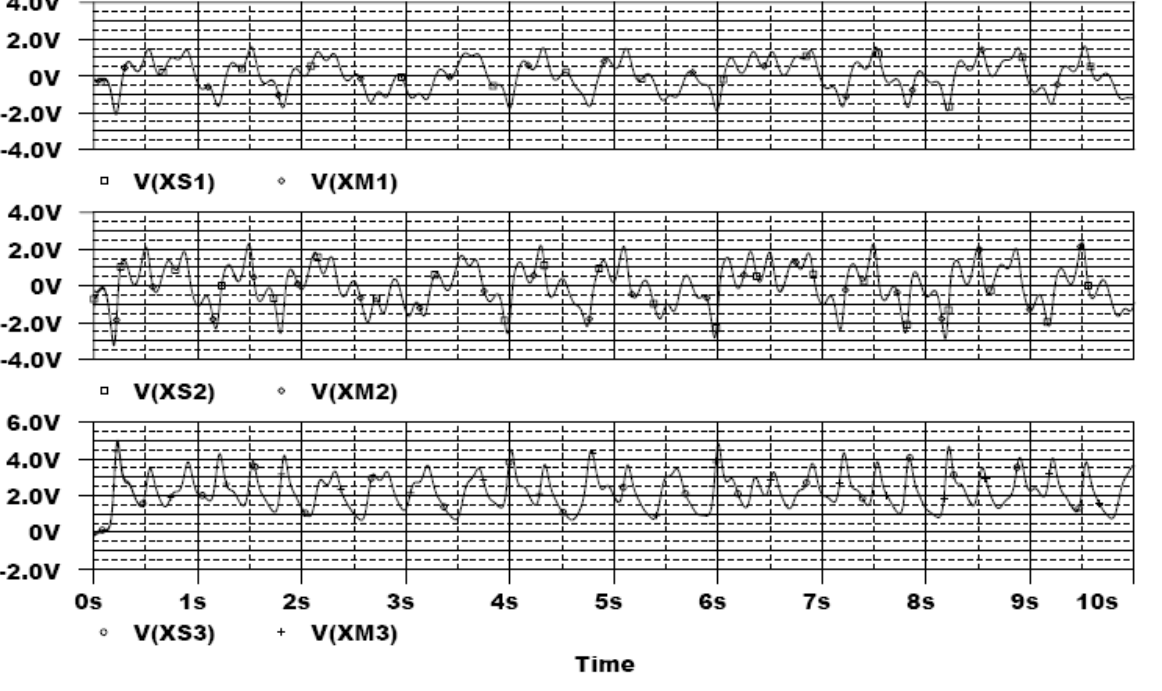
Figure 8. Experimental results of synchronization between state x